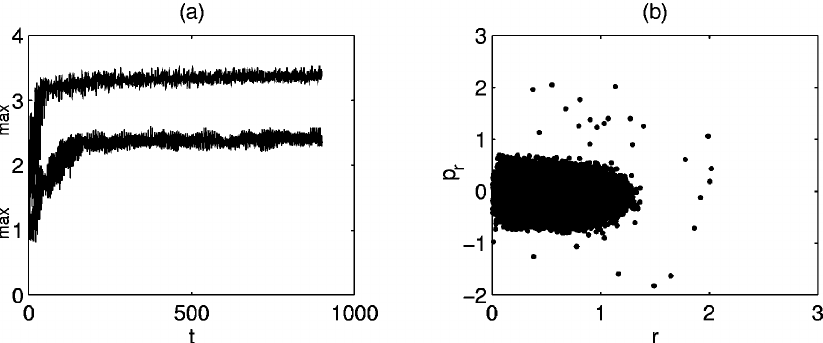
FIG. 18. Coupling effect for the 6D uniform distribution with zero transverse mismatch m (cid:120) (cid:173) m (cid:121) (cid:173) (cid:49)(cid:46)(cid:48)(cid:44) m (cid:122) (cid:173) (cid:49)(cid:46)(cid:53) ( (cid:99) (cid:121) (cid:97) (cid:173) (cid:50)(cid:44) h (cid:120) (cid:173) (cid:48)(cid:46)(cid:53)(cid:53)(cid:44) h (cid:122) (cid:173) (cid:48)(cid:46)(cid:52)(cid:53) ): (a) maximum (cid:120) and (cid:122) and (b) (cid:114) (cid:45) (cid:112) (cid:114) diagram at (cid:116) (cid:173) (cid:57)(cid:48)(cid:48) for particles with the angular momentum j (cid:76) j , (cid:48)(cid:46)(cid:49) (with 25000 particles plotted). (cid:122)